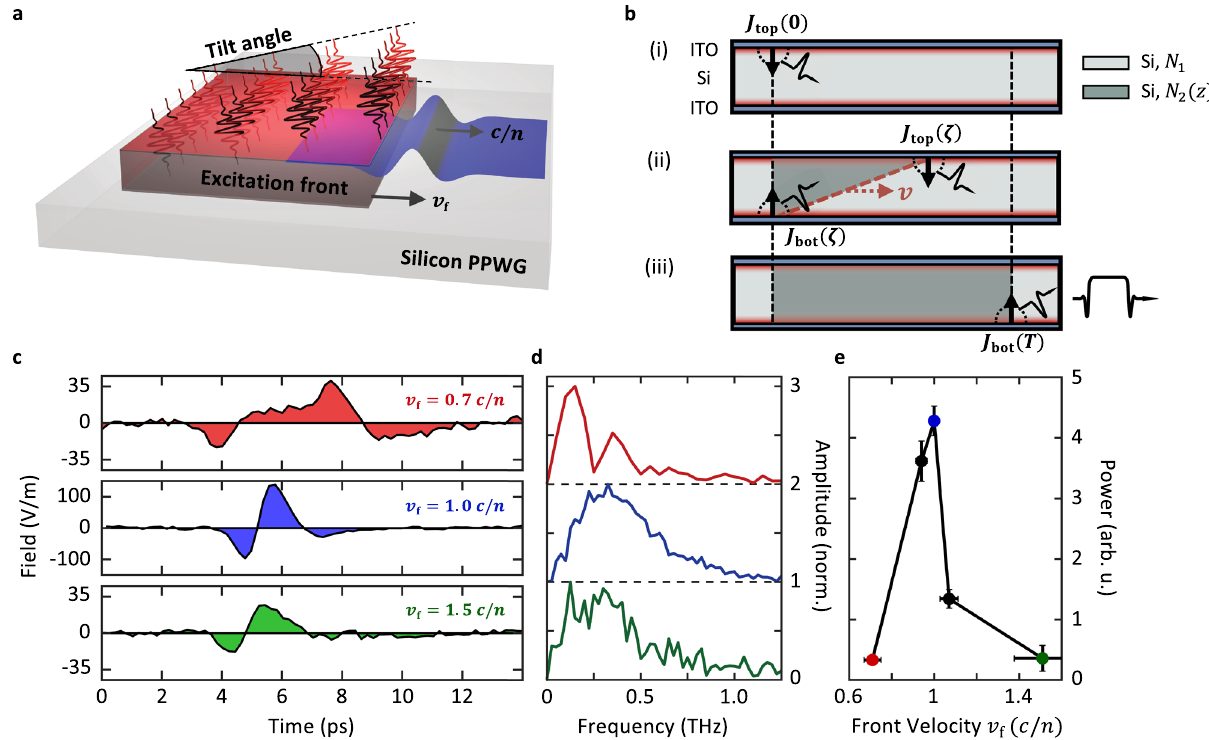
Fig. 1 Demonstration of the SLIPSTREAM platform. a Schematic of the SLIPSTREAM platform, generating and manipulating THz pulses using the injection of a near-infrared (NIR) pulse with a tilted intensity pro fi le into a Si- fi lled parallel plate waveguide (PPWG). The velocity of the intensity front v f is set by the tilt angle relative to the THz velocity c / n , where c is the vacuum speed of light and n is the refractive index. b Symbolic construction of a THz plateau pulse by the space-time-delayed, ultrafast switching of static Schottky currents built into the top ( J top ) and bottom ( J bot ) interfaces, shown in successive snapshots in time until the moving front has ended its travel at time t = T . c Measured THz transients typical of the sub-luminal, luminal and super-luminal regimes of front velocity for a maximal induced photocarrier density of approximately 5 × 10 16 cm 3 , with d the corresponding spectra normalized to unity. e Integrated spectral power peaking for the luminal case due to synchronicity with the emission, maximizing the interaction with the moving front. Each datapoint is an average over several scans and is accompanied by the standard deviation, and arb. u. stands for arbitrary